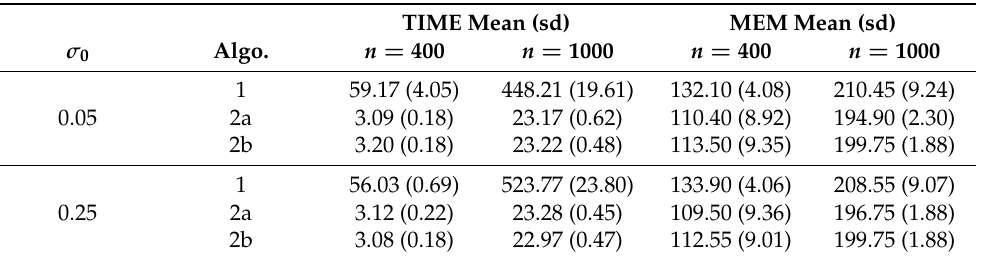
Table 7. Computation times (in sec) and memory consumption (in MB) for computing the three algorithms using different parameters in B = 100 repetitions. TIME Mean (sd) MEM Mean